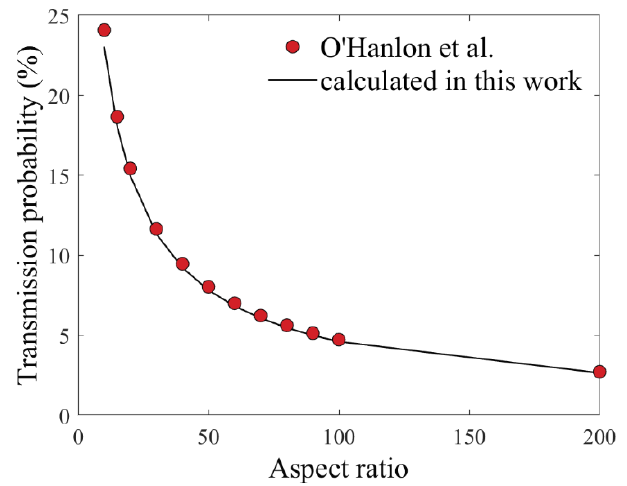
Figure 3. Transmission probability K calculated with Equation (3) (solid line) and data (dots) from O’Hanlon et al. Reproduced with permission from [27].